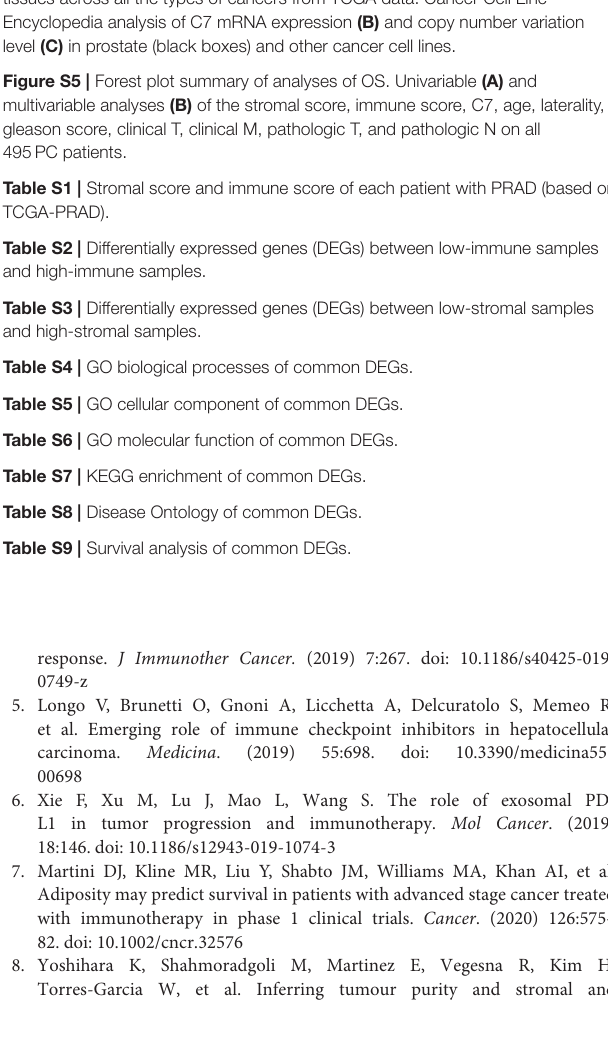
Figure S1 | Survival analysis of the association between immune score and overall survival (A) , disease-free survival (B) time in PC. Survival analysis of the association between stromal score and overall survival (C) , disease-free survival (D) time in PC. Figure S2 | (A) Expression comparison of candidate hub genes in PCs and normal tissues. (B) Stage plots of C7 across different T stages in GSE116918. (C) Stage plots of C7 across different clinical T stages in GSE70770. (D) Stage plots of C7 across different pathology T stages in GSE70770. Figure S3 | Oncomine database analyses. comparison of C7 mRNA expression across 12 analyses of PC. Figure S4 | (A) Comparison of C7 mRNA expression between tumors and normal tissues across all the types of cancers from TCGA data. Cancer Cell Line